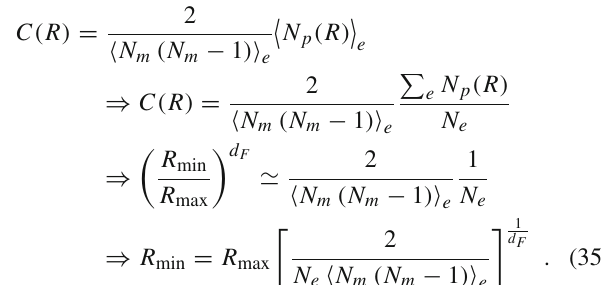
extracted by fits on the data F 2 , CI in graphs a. For comparison estima- tions from corresponding references are are 2